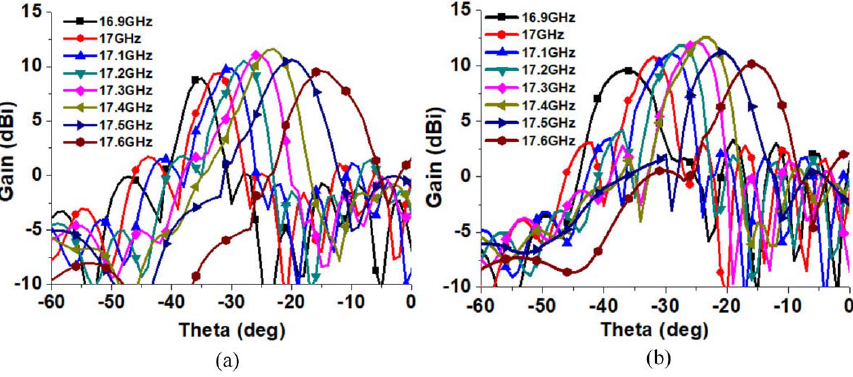
Figure 17. ( a ) The measured RHCP gain and ( b ) the measured LHCP gain of the proposed antenna in the x–z plane.